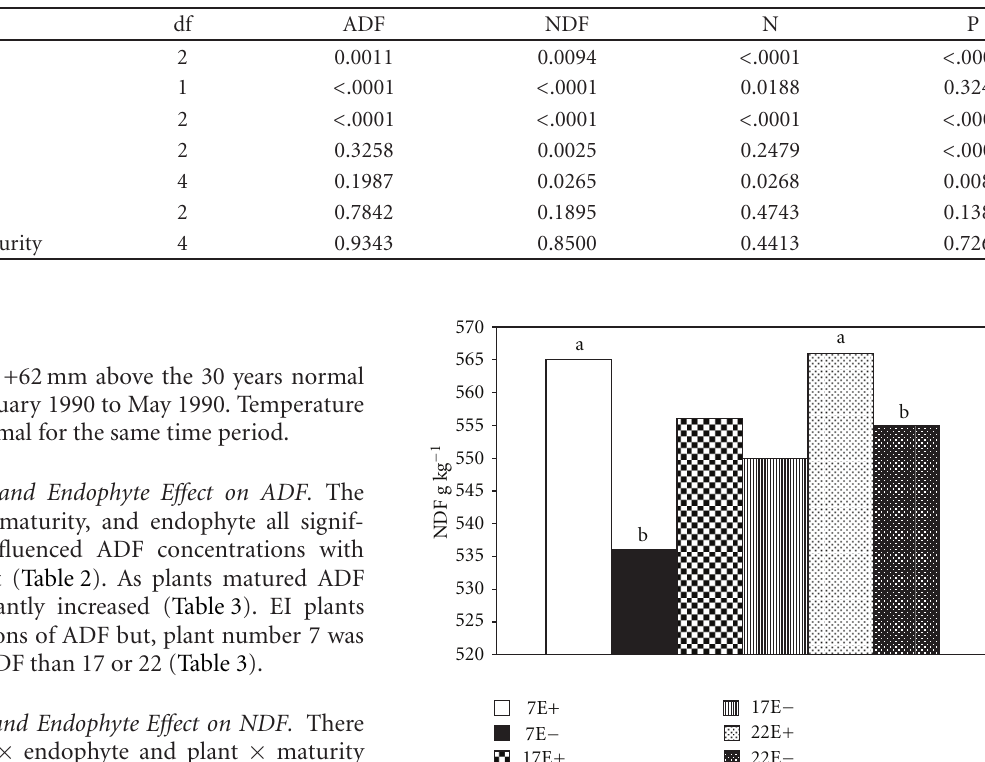
Table 2: Analysis of variance P -values for dry matter concentrations of ADF, NDF, N, and P content of endophyte infected and free tall fescue clones in the field study.